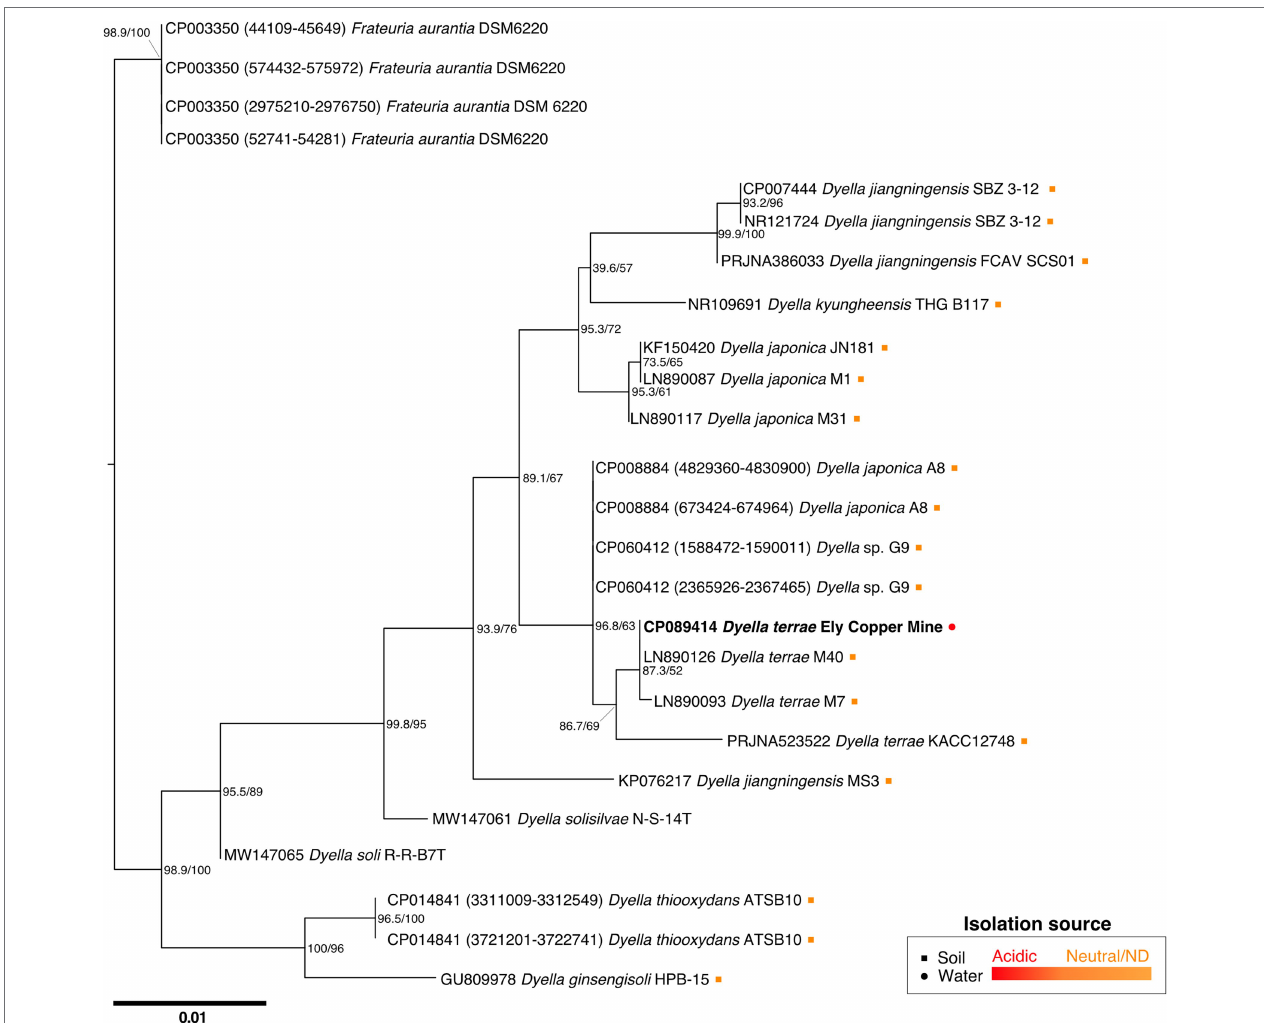
FIGURE 3 | Maximum likelihood tree based on near-complete 16S rRNA gene sequences showing the phylogeny of Dyella sp. Sequences of Frateuria were used as an outgroup. Bootstrap (left) and SH-like approximate likelihood ratio (right) support values are expressed in percentages at nodes. Bar represents 0.01 substitutions per nucleotide position. Circle and square symbols represent species isolated from water and soil, respectively. The colors of the symbols indicate whether the environment was acidic (red) or either neutral/no pH was reported (orange). Isolates without associated metadata have no